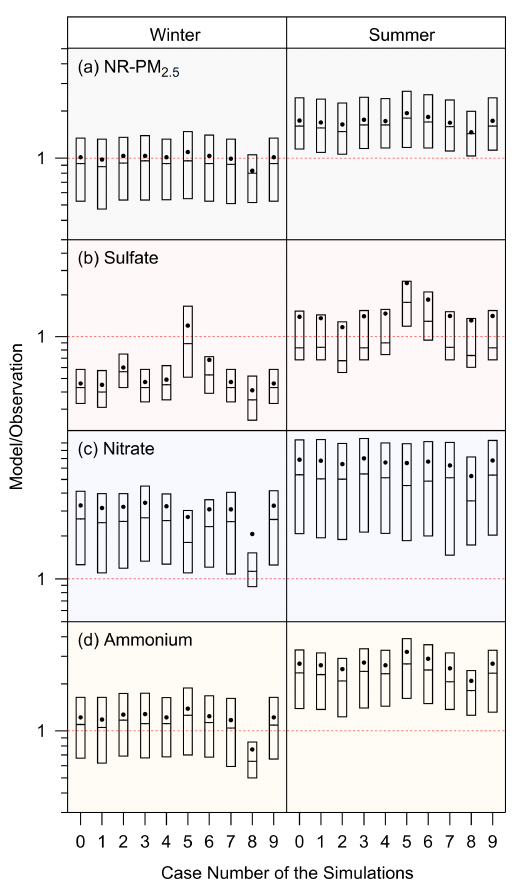
Figure 6. Box-and-whisker plots of the simulation-to-observation ratios of hourly mean mass concentrations of (a) NR-PM 2 . 5 , (b) sul- fate, (c) nitrate, and (d) ammonium for the standard simulation (i.e., Case 0) and Cases 1 to 9 during the selected wintertime and sum- mertime periods. The upper and lower edges of the boxes, the mid- dle lines, and the solid dots denote the 25th and 75th percentiles, the median values, and the mean values, respectively. The dashed red lines show the 1:1 simulation-to-observation